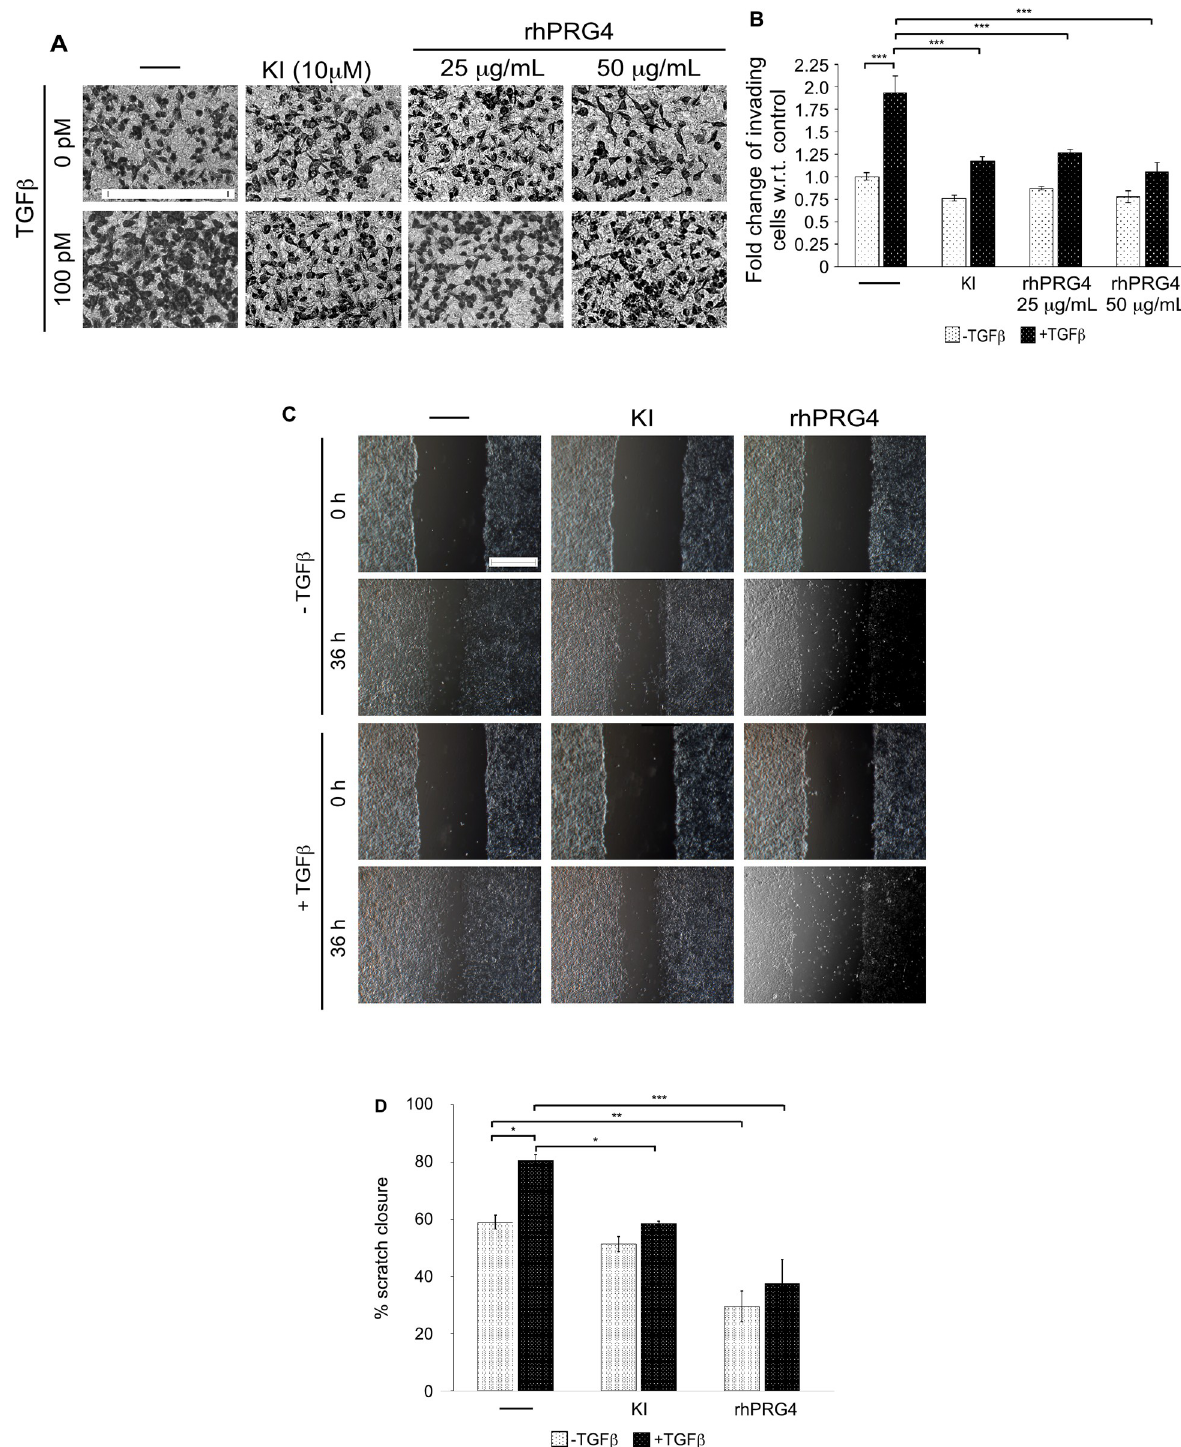
Fig 2. rhPRG4 suppresses breast cancer cells’ invasive and migratory abilities. (A) Representative DIC light microscopy images of crystal violet- stained 12h-serum-starved MDA-MB-231 cells appearing on the underside of Matrigel-coated membrane of a transwell insert, with the bottom well containing complete growth medium without (-) or with 100 pM TGF β , alone or with 10 μ M of T β RI inhibitor SB435142 (KI), 25 μ g/mL rhPRG4 or 50 μ g/mL rhPRG4. Scale bar represents 150 μ m. (B) Bar graph depicts mean ± SEM fold change of invaded cells relative to control counted from eight randomly chosen non-overlapping fields for each experimental conditions from five independent experiments including the one shown in A.